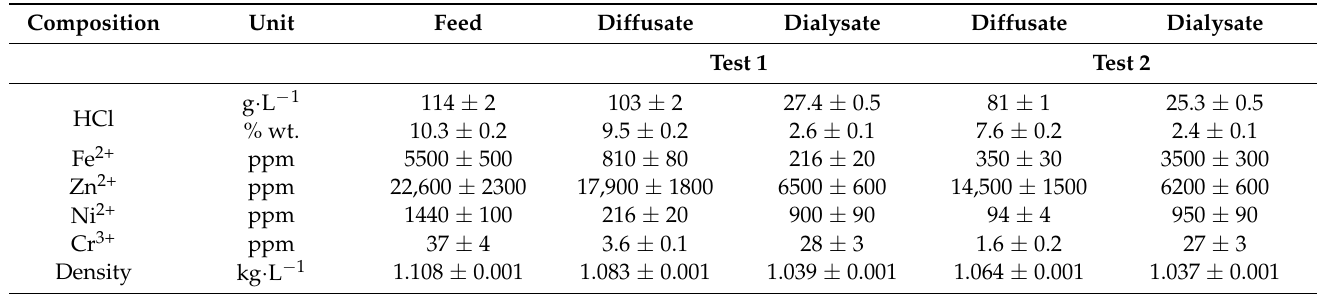
Table 3. Analytical results of the output streams for Test 1 and Test 2.